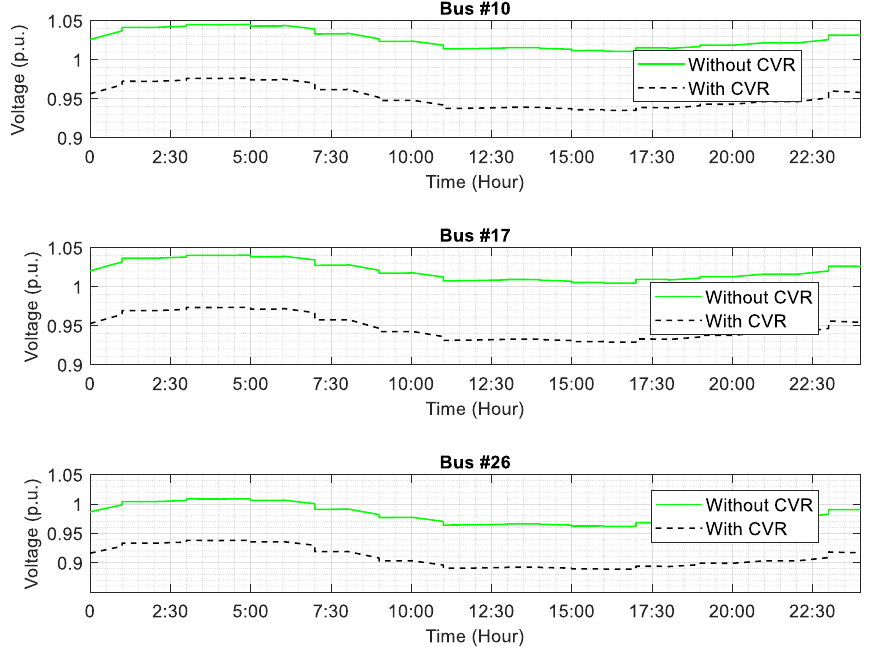
/ without CVR in the presence of DG. Figure 13. Case V: Voltage vs. time with/without CVR in the presence of DG. Figure 13. Case V: Voltage vs. time with